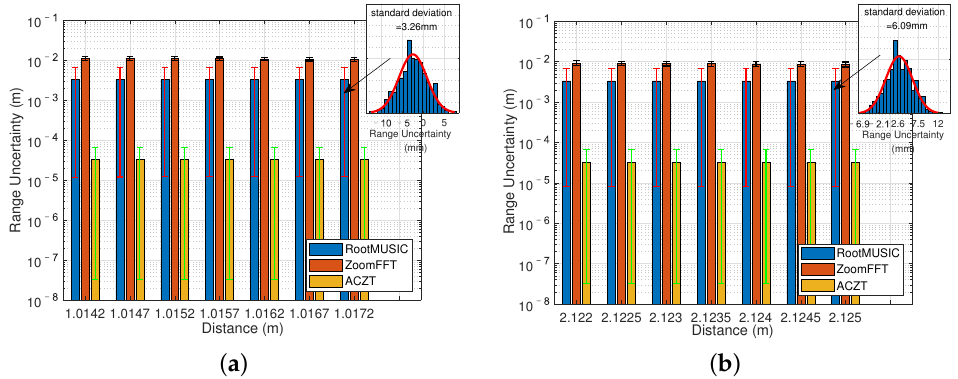
Figure 12. The experiment results by three different algorithms when the distance between the radar and the center of the track 1 is different. The height of ( a ) is 1.0157 m; The height of ( b ) is 2.1235